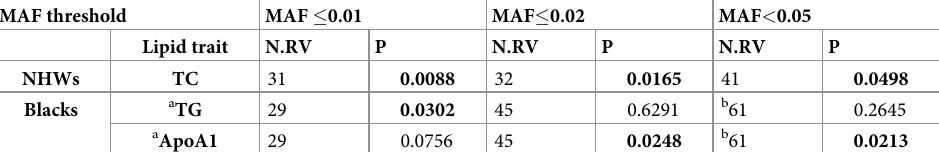
= � Analysis was performed using SKAT-O (optimal sequencing Kernel association test); N.RV: number of variants with the defined MAF. Significant covariates that were included in all association analyses were age, gender, smoking, and BMI in NHWs and gender, age, BMI, waist measurement, smoking, exercise, and staff level in Blacks. a Box-Cox transformed variables. b Includes 60 variants with MAF < 0.05 and one variant with borderline MAF of 0.0499.